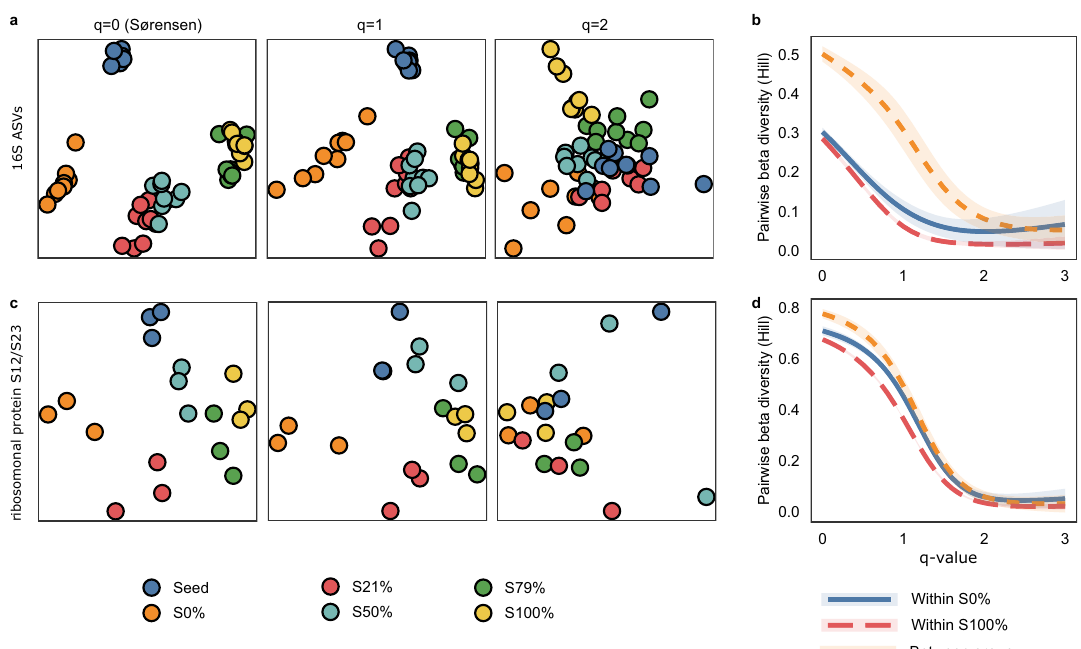
Fig. 2 Beta-diversity of the bio fi lm communities. Beta-diversity of 16S rRNA ASVs ( a , b ) and of the metagenomics dataset using the ribosomal protein S12/S23 ( c , d ), based on Hill numbers. a , c PCoA when q = 0 (i.e. the Sørensen index), q = 1 or q = 2; each circle corresponds to a bio fi lm carrier. b , d Within group and between group beta-diversity for bio fi lms kept in the mainstream (S0%) and moved to the sidestream (S100%) at different q -values; the lines show the average pairwise beta-diversity and the shaded areas show 95% con fi dence